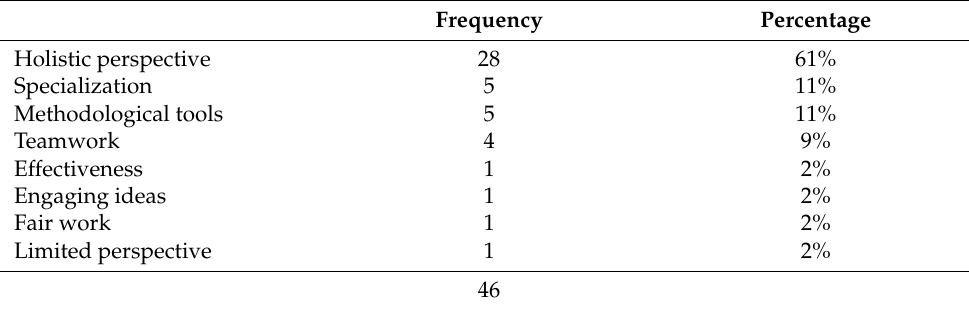
Table 2. Benefits of team